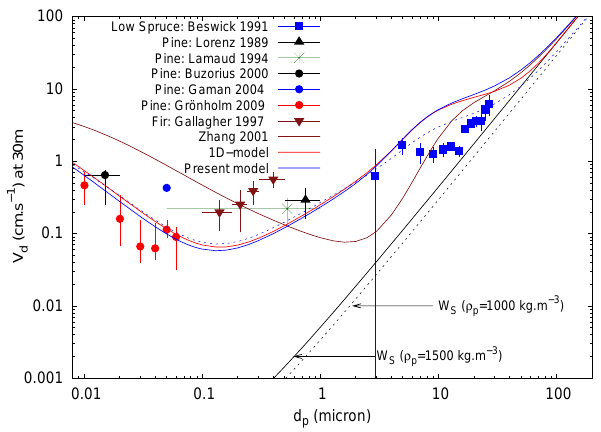
Fig. 5. Deposition on coniferous forest, as measured by Beswick et al. (1991); Lorenz and Murphy (1989); Lamaud et al. (1994); Bu- zorius et al. (2000); Gaman et al. (2004); Gr¨onholm et al. (2009); Gallagher et al. (1997). A friction velocity of 47.5cms − 1 , a particle density of 1500kgm − 3 and the parameters of the LUC 4 are used to run the model of Zhang et al. (2001, in plain brown), the 1-D-model (in plain red) and the present model (in plain blue). Are added in blue dots the predictions of the present model obtained under the configuration of Beswick et al.’s experiment: u ∗ = 37cms − 1 , h = 4 . 2m, h c = 1m, LAI = 10, z 0 = 0 . 3m and d = 2 . 8m, ρ p = 1000kgm − 3 . All deposition velocities are re-calculated at z R =